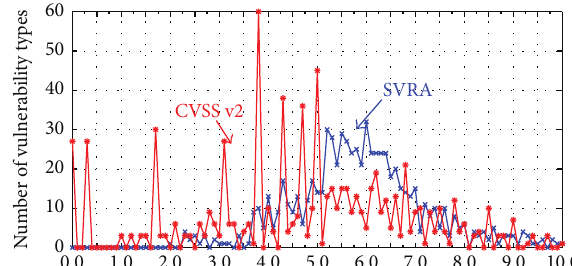
Figure 9: Theoretical distributions of SVRA and CVSS v2, where 𝑇 = {2002, 2003, .. .} and 𝑡 = 2012 .